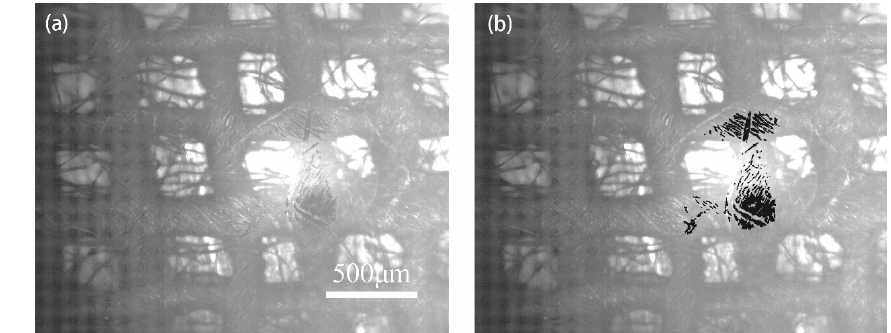
Fig. 3 Images of (a) original and (b) processed contact